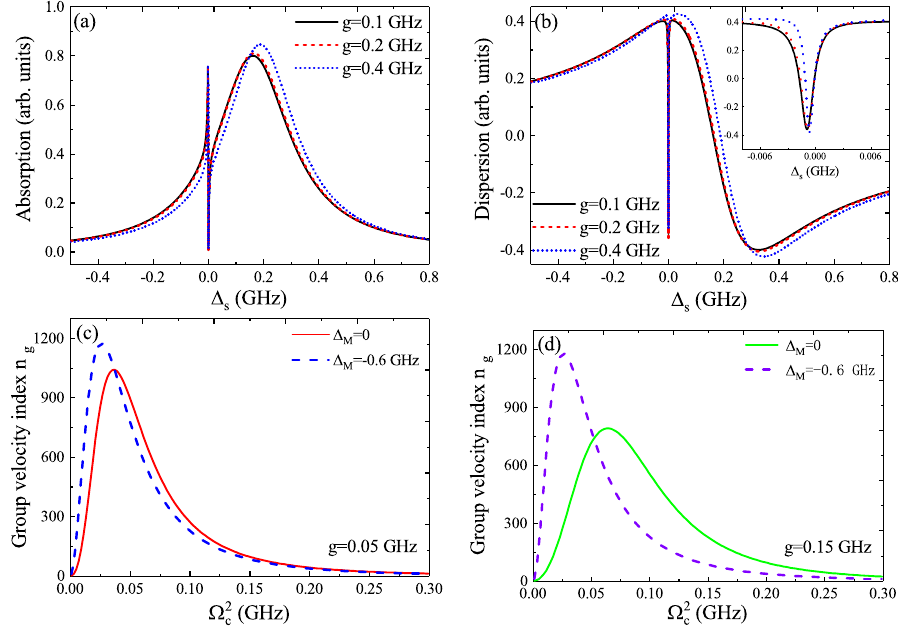
Figure 5. ( a , b ) The absorption and dispersion as a function of ∆ s for three different QD–MF coupling g under the parameters of β = 0.06, ∆ M = − 0.6 GHz, ∆ c = ω m , and Ω 2 c = 0.1 (GHz) 2 . ( c , d ) The group velocity index n g versus Ω 2 c for QD–MF coupling g = 0.05 GHz and g = 0.15 GHz,